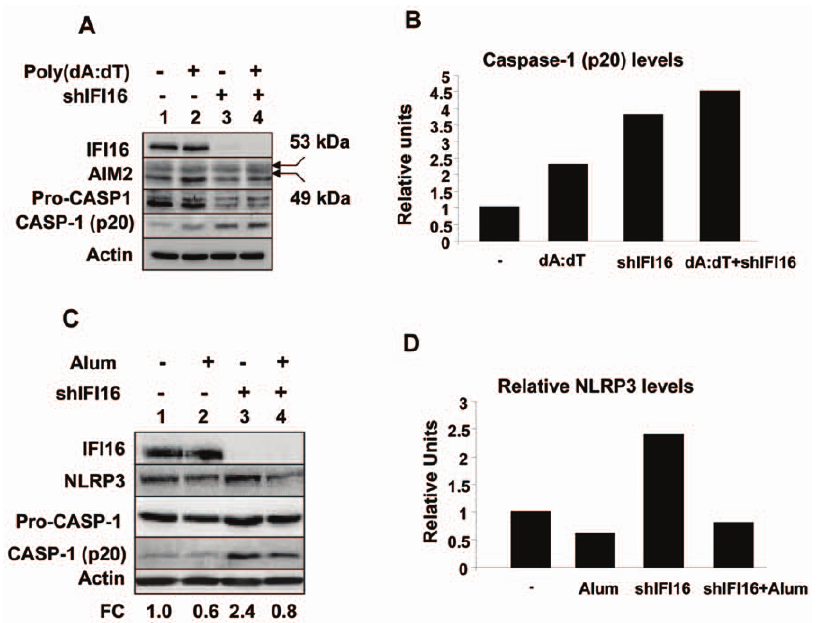
Figure 6. Knockdown of IFI16 expression increases casapase-1 activation by the AIM2 inflammasome. ( A ) Control THP-1 cells (lanes 1 and 2) or cells in which we knocked down the expression of IFI16 protein (lanes 3 and 4) were incubated with PMA (20 nM) for 14 h and then treated with LPS (1 m g/ml) for 3 h. Cells were then nucleofected without DNA (lanes 1 and 3) or with 2 m g of poly(dA:dT). After nucleofections, cells were incubated for 1.5 h and total cell lysates containing equal amounts of proteins were analyzed by immunoblotting using antibodies specific to the indicated proteins. The arrowheads indicate the bands corresponding to the indicated proteins. FC, indicates the fold change in the levels of the activated caspase-1 (the p20 protein band) with respect to the control lane 1. ( B ) Relative levels of caspase-1 (p20) protein shown in the panel A (lanes 1-4). ( C ) Control THP-1 cells (lanes 1 and 2) or cells in which we knocked down the expression of IFI16 protein (lanes 3 and 4) were incubated with PMA (100 nM) for 3 h and then treated with LPS (1 m g/ml) for 3 h. Cells were then either left untreated (lanes 1 and 3) or treated with alum (300 m g/ml) for 150 min. Total cell lysates containing equal amounts of proteins were analyzed by immunoblotting using antibodies specific to the indicated proteins. FC, indicates the fold change in the levels of the pro-caspase-1 with respect to the control lane 1. ( D ) Relative levels of NALP3 protein shown in the panel C (lanes 1–4).